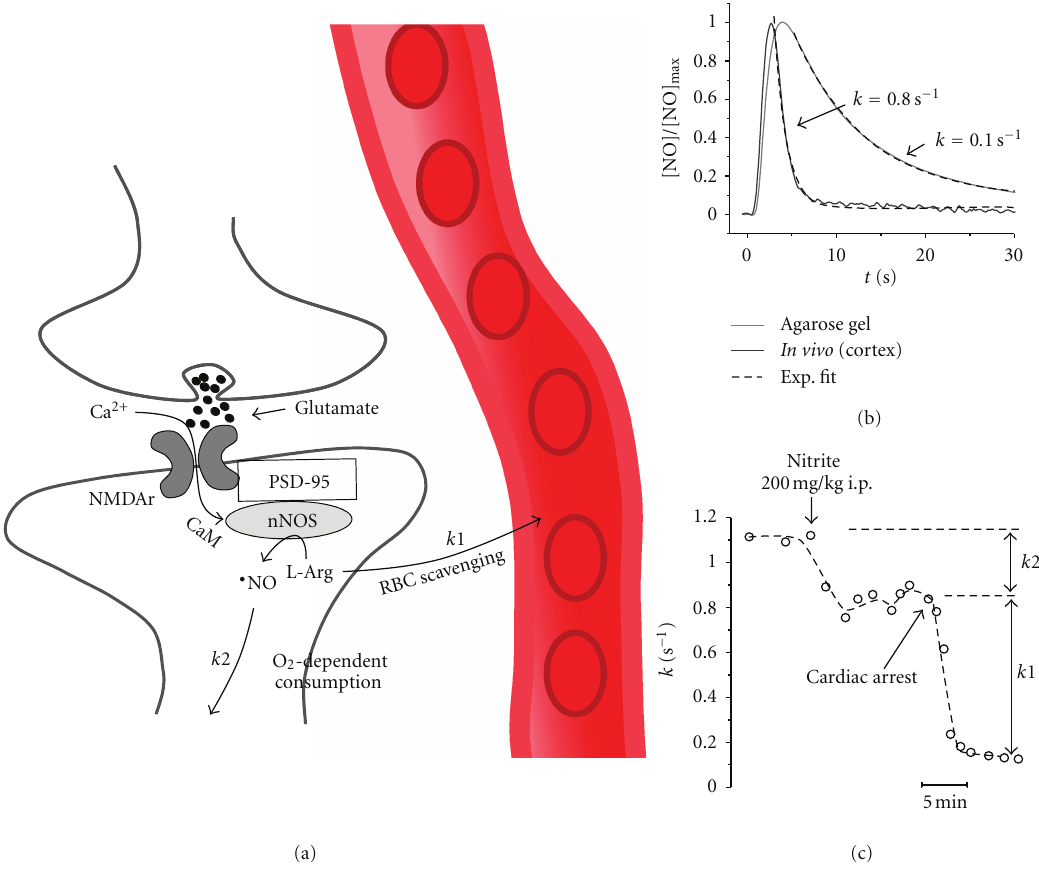
Figure 1: The major pathways of • NO production and inactivation in the brain. (a) • NO is synthesized following calcium entrance into the postsynaptic density (upon glutamate activation of NMDA receptors). Calcium activates nNOS by promoting Calmodulin (CaM) binding to the enzyme. • NO rapidly di ff uses to neighboring tissue, being inactivated both by O 2 -dependent mechanisms and by scavenging by circulating erythrocytes (RBCs). (b) Typical electrochemical signals obtained using microelectrodes in the rat brain in vivo and in agarose gel following local application of small volumes (few nL) of • NO solution. First-order decay constant values ( k ) were used to quantify the decay profiles. (c) Anoxia, induced by a nitrite lethal dose, induced a 20% decrease in k ( k2 ), in contrast with a large decrease in k following cardiac arrest, suggesting that the major route of • NO inactivation in the brain in vivo is by circulating RBCs scavenging ( k1 ). Adapted from